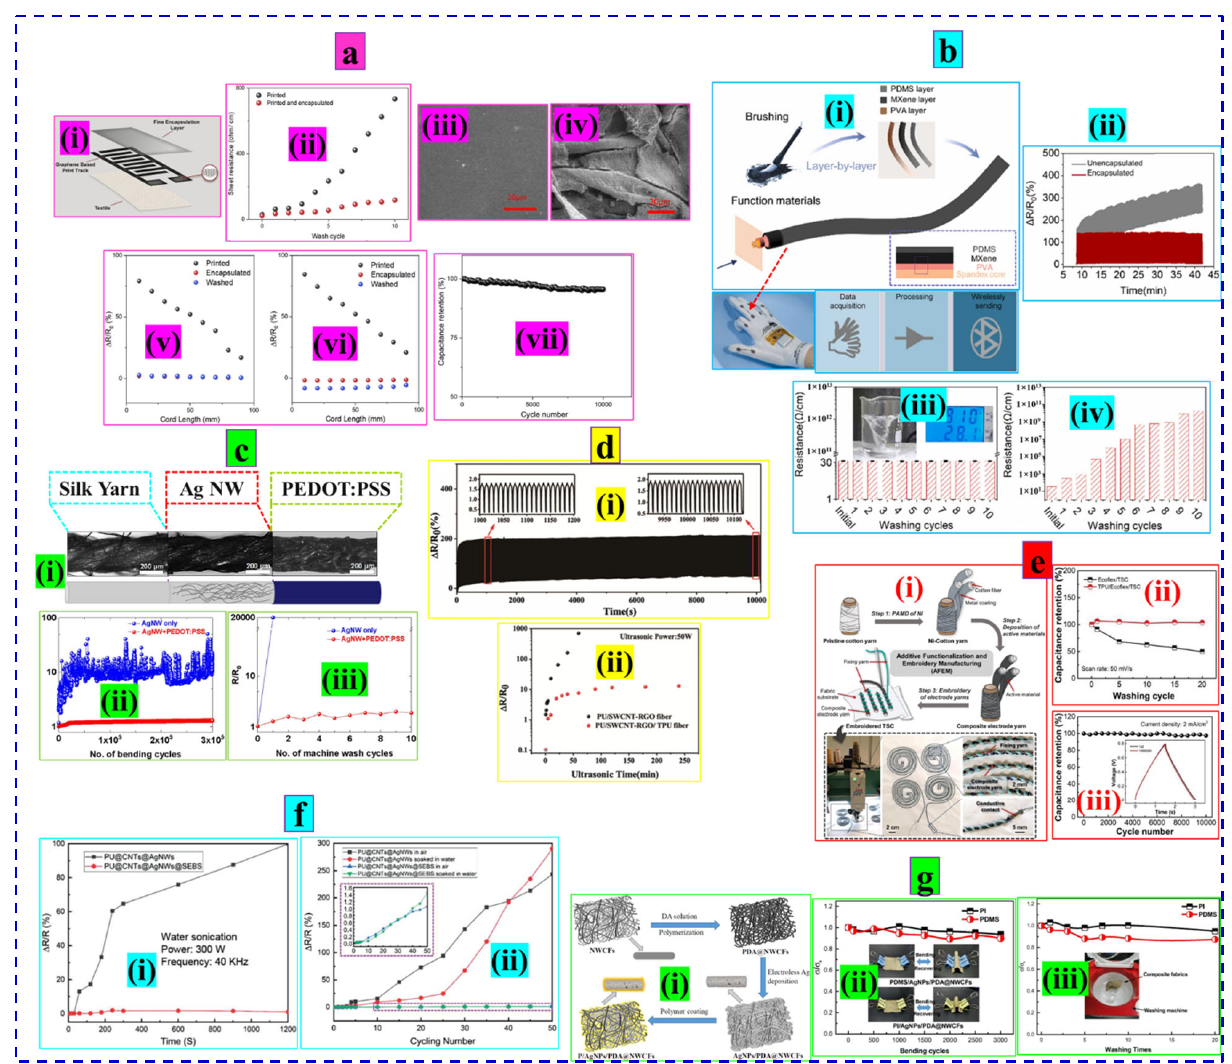
Figure 8. Different encapsulation strategies. ( a ) (i) Schematic of the encapsulated substrate, (ii) Change of resistance upon ten washing cycles, (iii,iv) SEM images of the encapsulated and unencapsulated fabric after washing, (v,vi) Variations in resistance upon repeated bending and compression in the forward direction, (vii) Capacitance retention under 10,000 operation cycles. Reproduced with permission [235] Copyright 2022, Cell Press. ( b ) (i) Schematic of the encapsulated fiber fabrication process, (ii) Stability under 500 stretch ‐ release cycles, and (iii,iv) washability of the unencapsulated and encapsulated sample. Reproduced with permission [236] Copyright 2022, Elsevier. ( c ) (i) Schematic and optical images of the different sections of the functional silk yarn, (ii) Cyclic stability, and (iii) washability performance of the substrate. Reproduced with permission [237] Copyright 2020, American Chemical Society. ( d ) (i) Stability of the TPU encapsulated SWCNT ‐ RGO/PU yarn under 1000 stretching/releasing, (ii) Durability against 250 h ultrasonic washing. Reproduced with permission [238] Copyright 2021, Springer. ( e ) (i) Schematic of the yarn ‐ shaped supercapacitor with different (Eco flex/TPU) encapsulation, (ii) washability, and (iii) operation stability. Reproduced with permission [239] Copyright 2020, Wiley. ( f ) (i) Change in resistance of the core ‐ sheath yarn with/without encapsulation under 50% cyclic strain in water and air, (ii) Underwater sonication. Reproduced with permission [162] Copyright 2019, Wiley. ( g ) (i) Schematic of the nonwoven fabric functionalization and encapsulation process, (ii) conductivity ration with 3000 bending cycles, and (iii) repeated washing. Reproduced with permission [240] Copyright 2021, Elsevier.